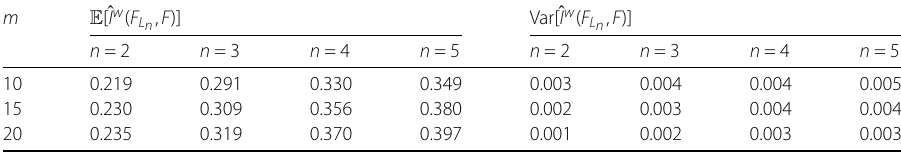
, F )] and Var[ ˆ I w ( F L